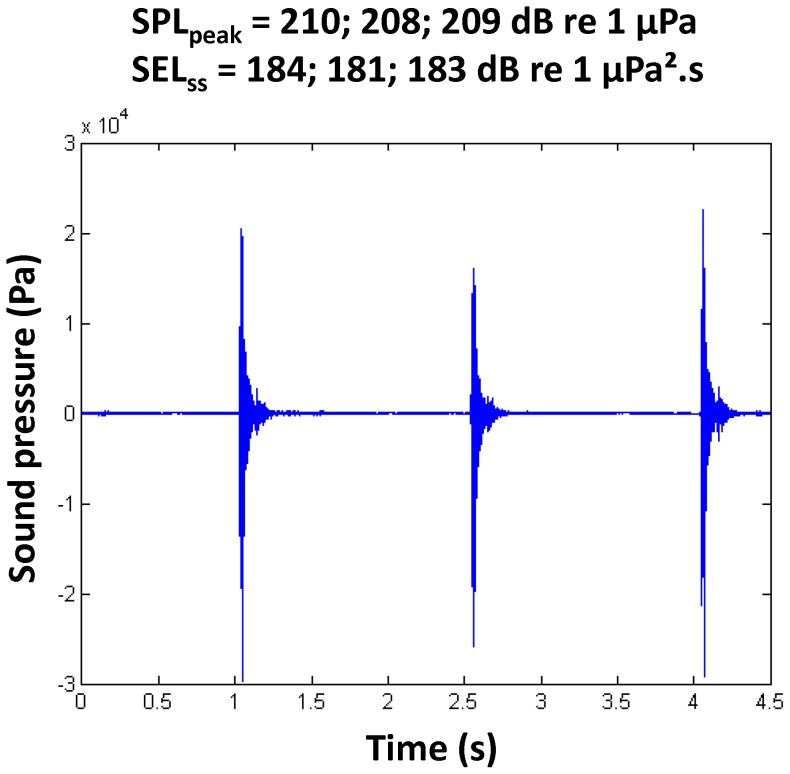
Detail of three consecutive piling strike signals.Detail of three consecutive piling strike signals recorded in the field for underwater sound pressure during experiment 3 (G7) (strike number 3005–3007 at 4892–4896.5 s).